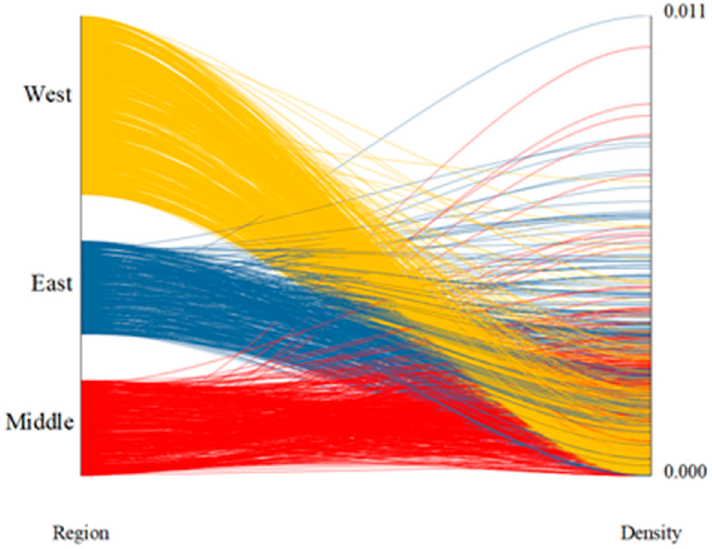
Figure 7. Parallel plot of the proportion differences of land used for transportation at the county level in the eastern, central, and western regions of China.